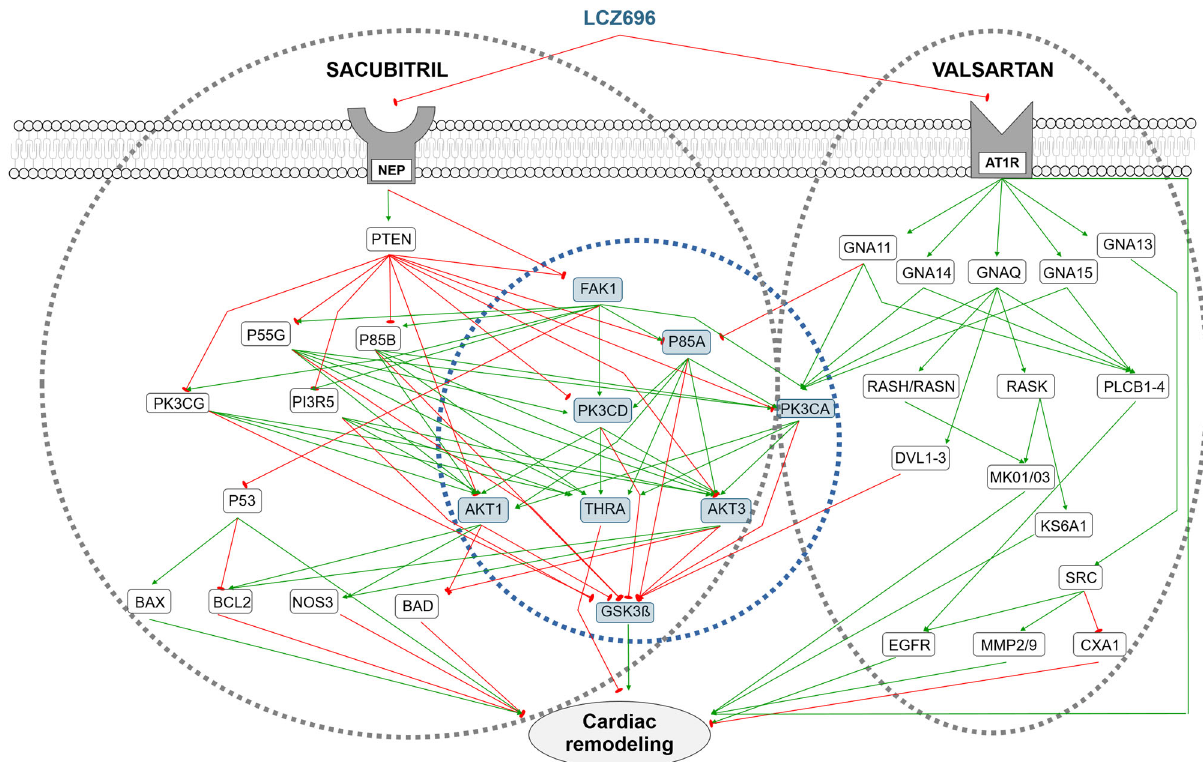
Fig. 2 Sacubitril/Valsartan ’ s MoA. Every relationship depicted represents a mechanism by which the drug could directly or indirectly (via downstream effectors) improve or reverse pathological cardiac remodeling, either through the activation ( green arrows ) or inhibition ( red arrows ) of downstream proteins. The same synergistic MoA was identi fi ed for both, MI and HF, cohorts; therefore, the depiction applies for both of them. Gray dotted-line circles encompass the proteins affected either by Sacubitril, Valsartan, or both. Blue dotted-line circle encompass the core of eight proteins that the mathematical models predict to act synergistically, by being related to both, Sacubitril and Valsartan, pathways in some